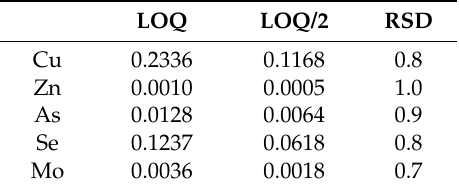
Table A1. The limit of quantification and